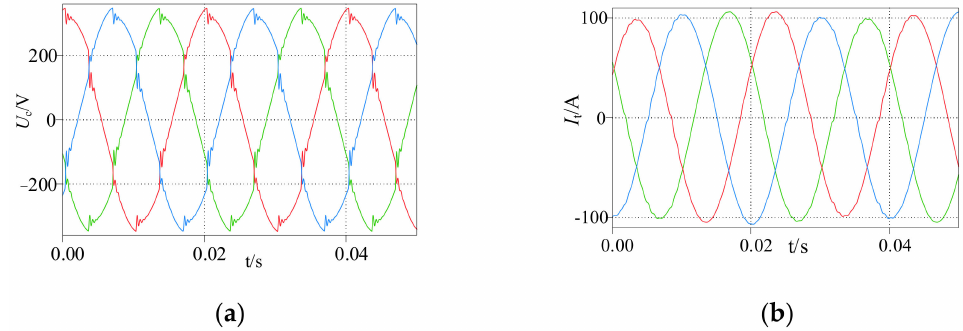
Figure 15. ( a ) Voltage of the GFM converter ( P set = 140,000 W, SCR = 29.04); ( b ) current of the GFL converter ( P set = 22,000 W, SCR = 4.84). (Green for phase A, red for phase B, blue for phase